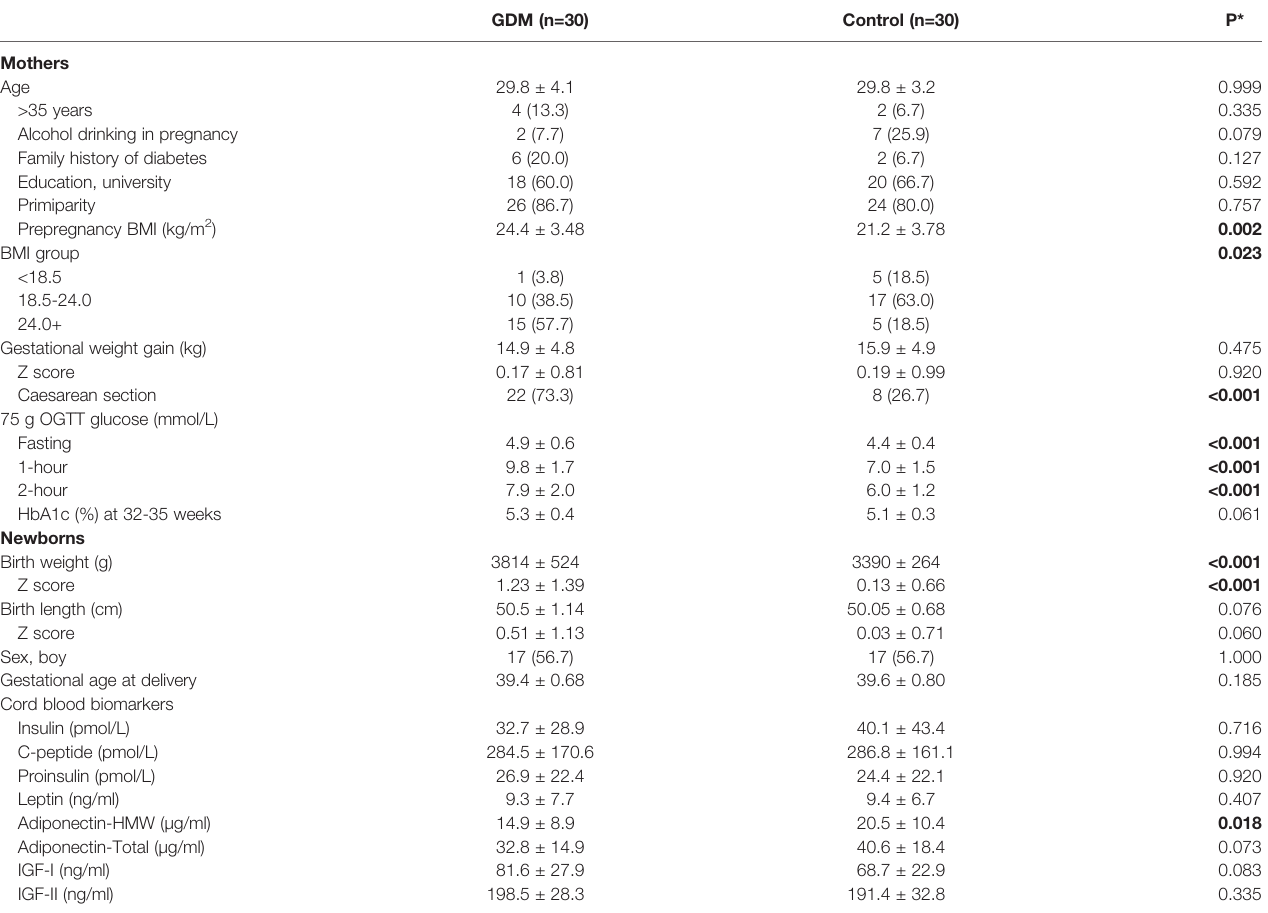
GDM (n=30) Control (n=30) P*